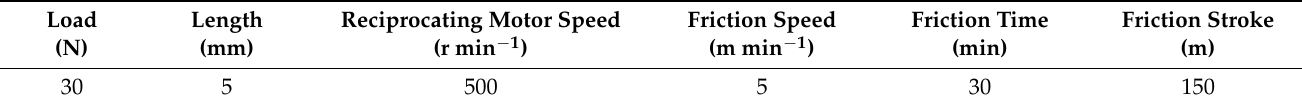
Table 2. Friction and wear test